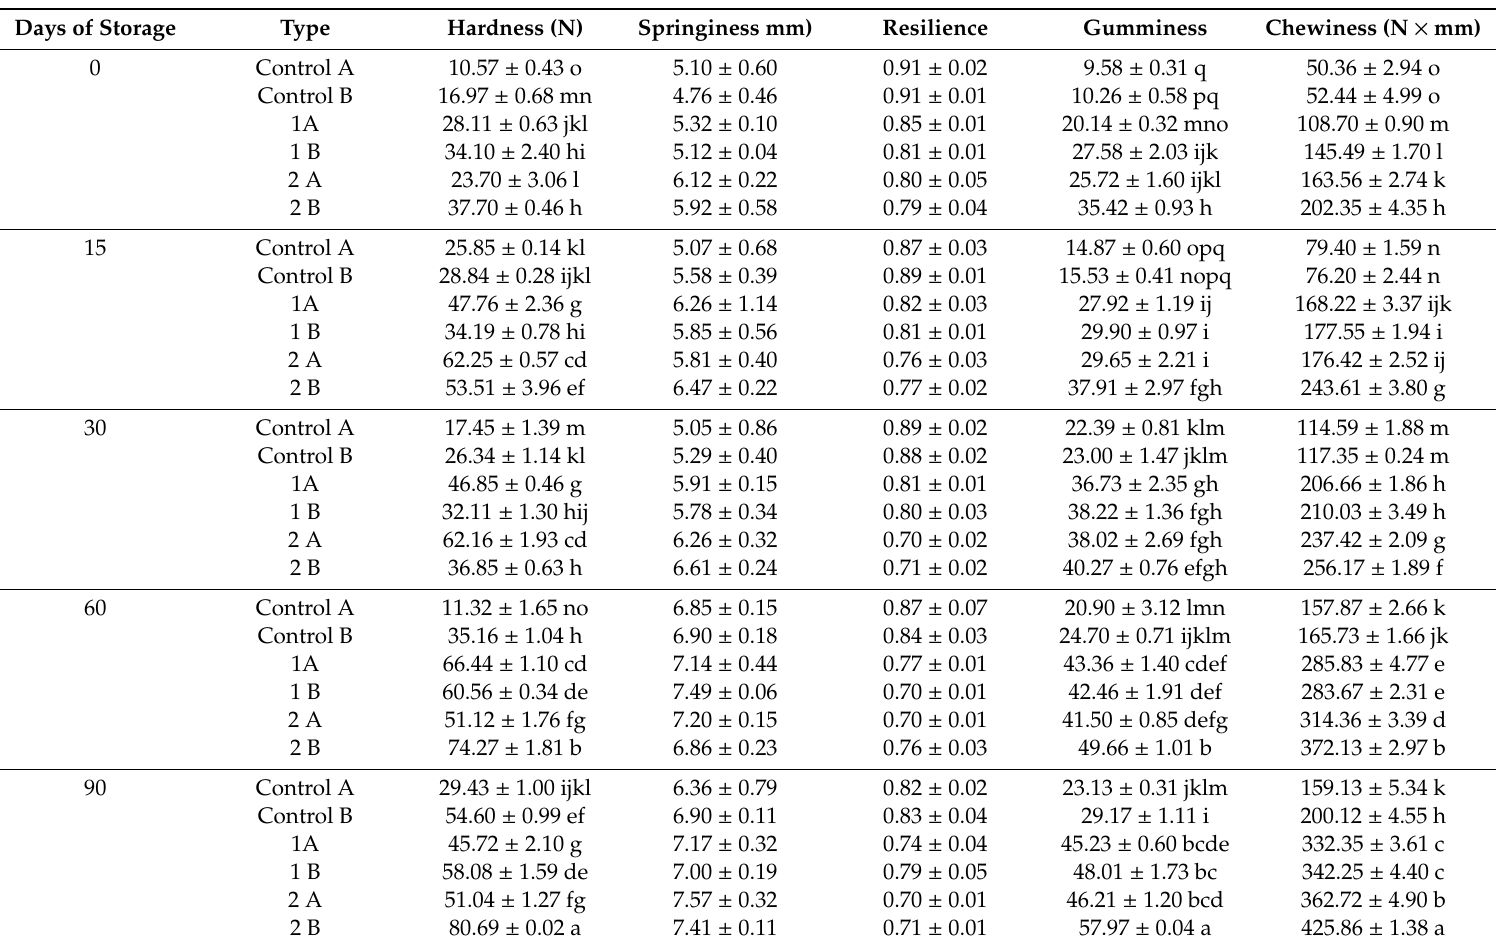
Table 6. Evaluation of textural parameters of bread samples produced using di ff erent types and levels of sea salt during storage (data are means ± standard